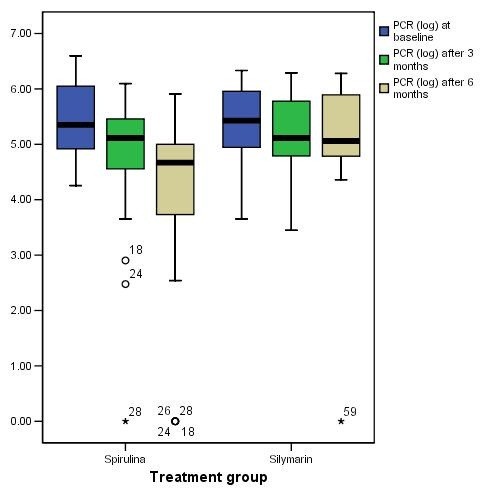
Boxplot graph representation of log transformed virus load (Log PCR) in each treatment group.